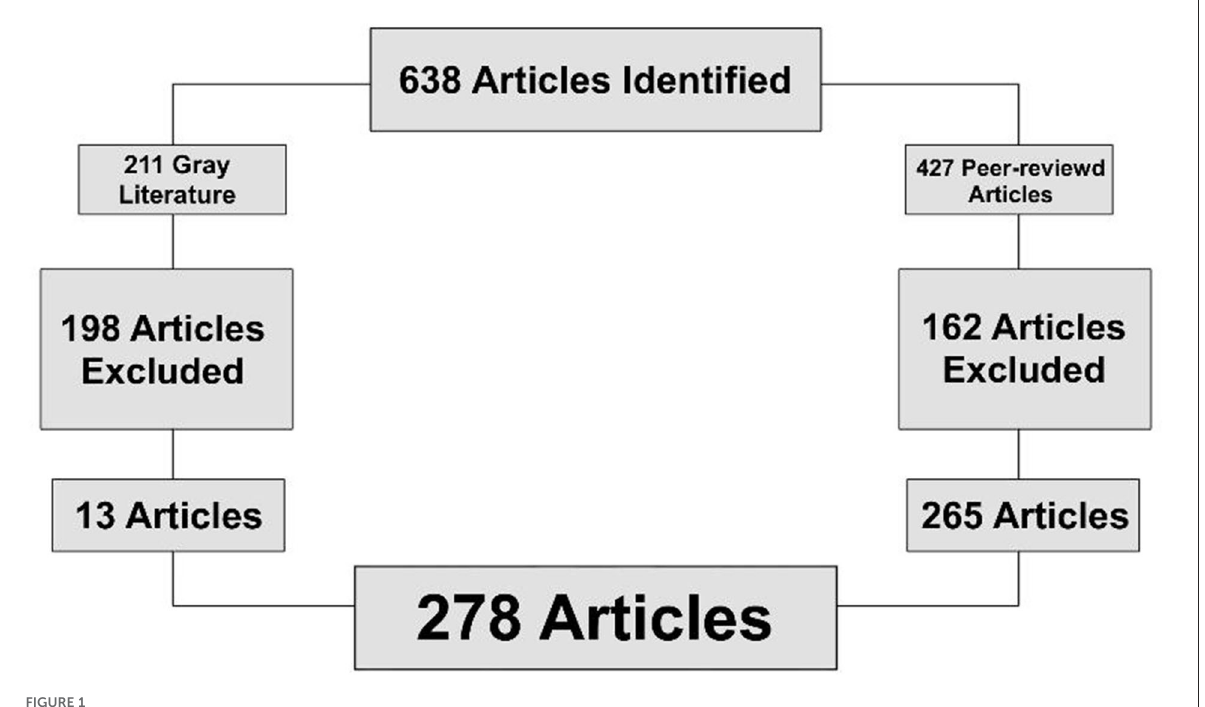
FIGURE1 Diagram of study